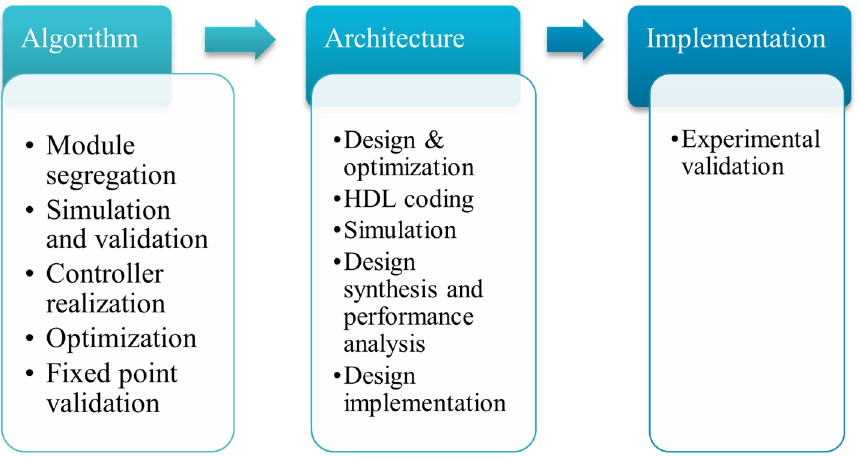
Figure 3. The design process of the FPGA controller.